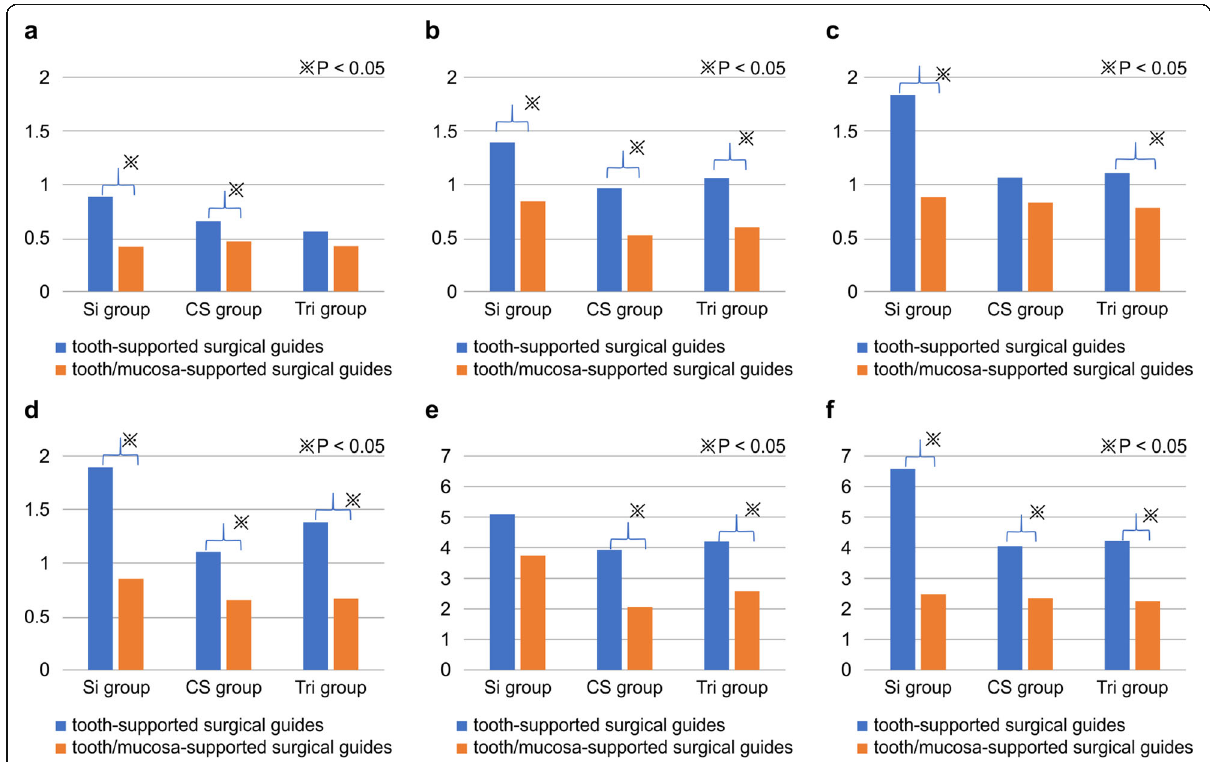
Fig. 7 Comparison of tooth-supported and tooth/mucosa-supported guided surgeries. a Three-dimensional (3D) deviation at the crest in 45. b 3D deviation at the crest in 47. c 3D deviation at the apex in 45. d 3D deviation at the apex in 47. e Angular deviation in 45. f Angular deviation in